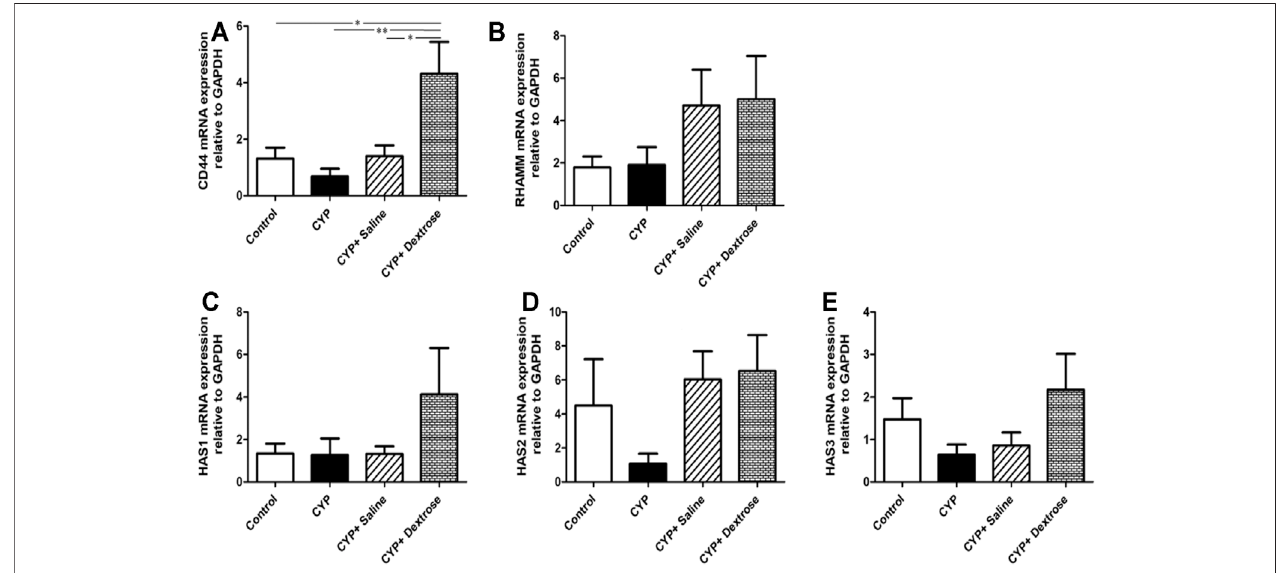
FIGURE 6 | mRNA expression of bladder tissues in interstitial cystitis rat model. (A) Cell surface antigen 44 (CD44); (B) receptor for hyaluronic acid-mediated motility (RHAMM); (C) hyaluronic acid synthesis 1 (HAS1); (D) hyaluronic acid synthesis 2 (HAS2); (E) hyaluronic acid synthesis 3 (HAS3). (* p ≤ 0.05; ** p ≤ 0.01; *** p ≤ 0.001).